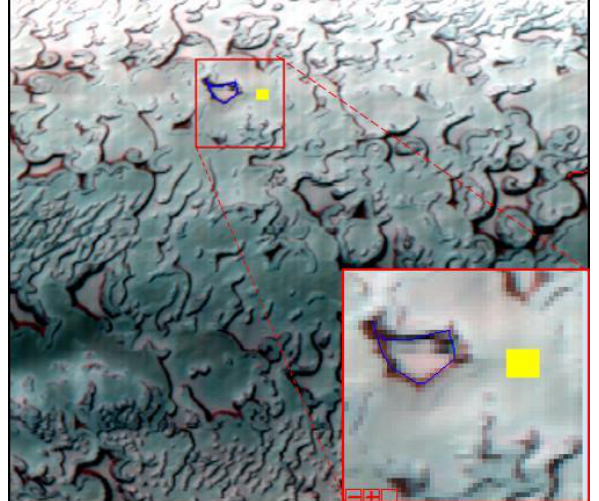
Figure 7: RGB visualisation of CRISM Scene 00005D24 with regions of interest inset